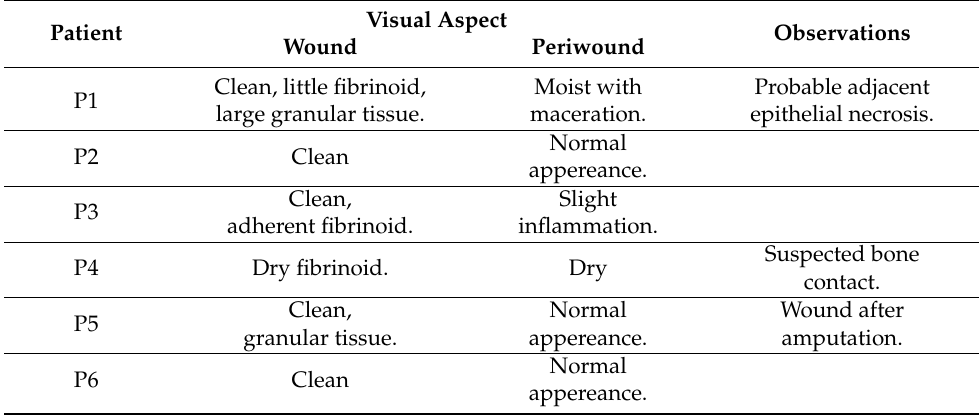
Table 2. Results of the clinical visual assessment of wounds in the lower extremities of the 6 patients for which we created the 3D color and thermal model with the proposed methodology.